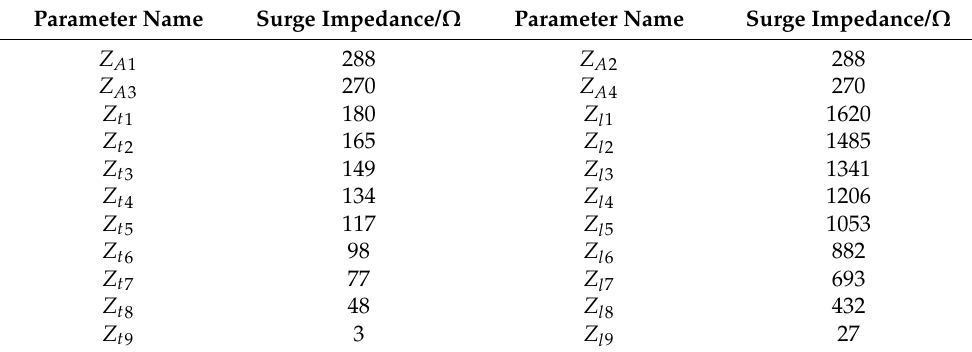
Table 5. Parameters for eight segments of the nominal